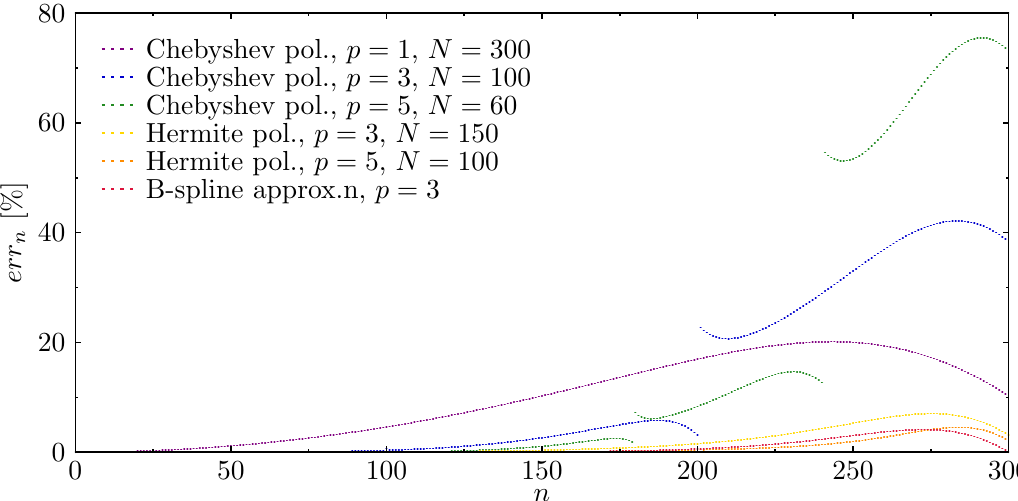
Figure 5. Relative errors of natural frequencies of the rod calculations based on different approximation polynomials, in the case of the rof with fixed